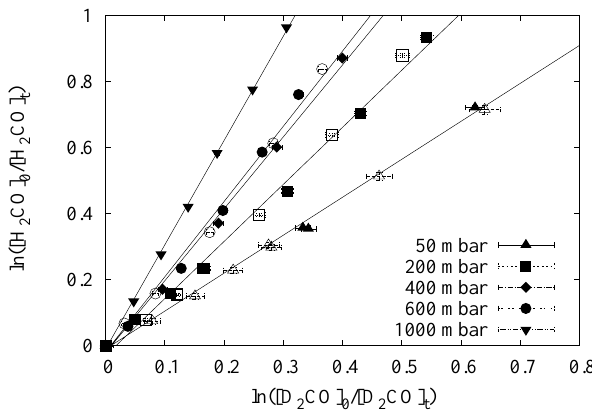
Fig. 2. Relative rate plots of H 2 CO vs. D 2 CO at the different pres- sures; closed and open symbols at pressures 50, 200 and 600mbar represent different experiments.